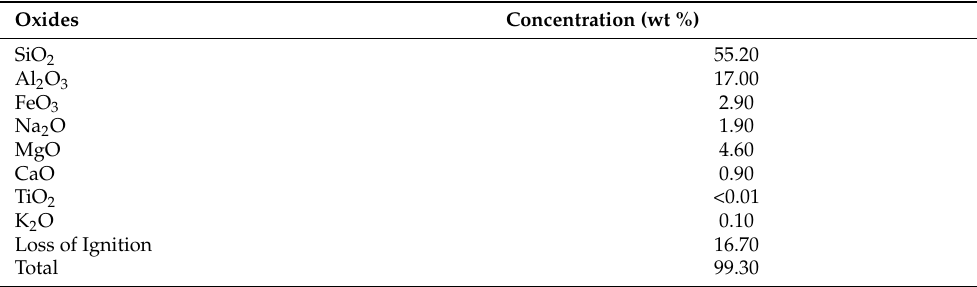
Table 1. Chemical composition of OCMA grade bentonite.